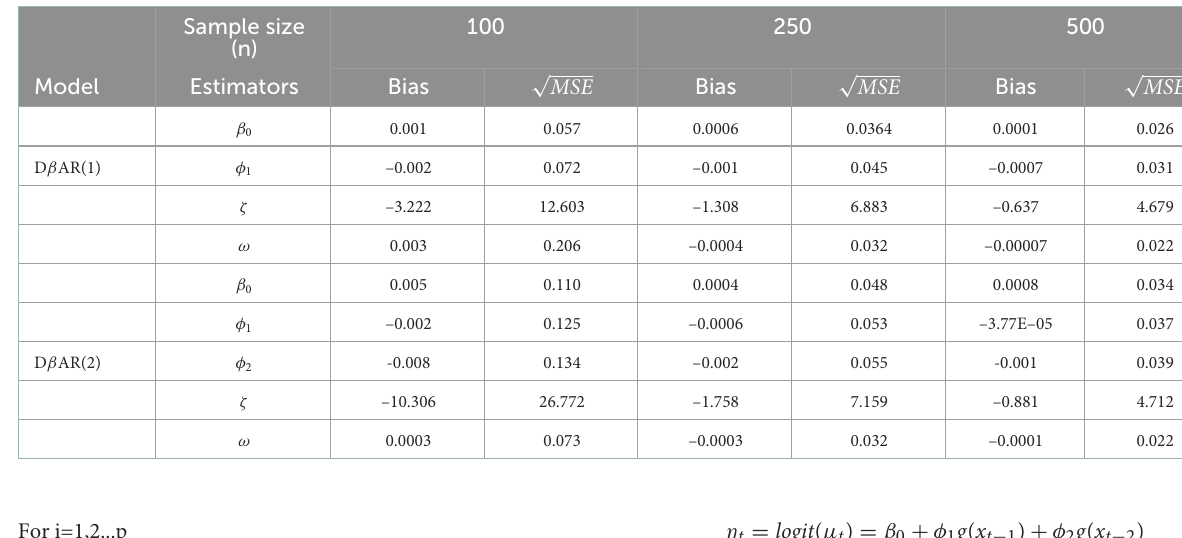
TABLE 1 Simulation